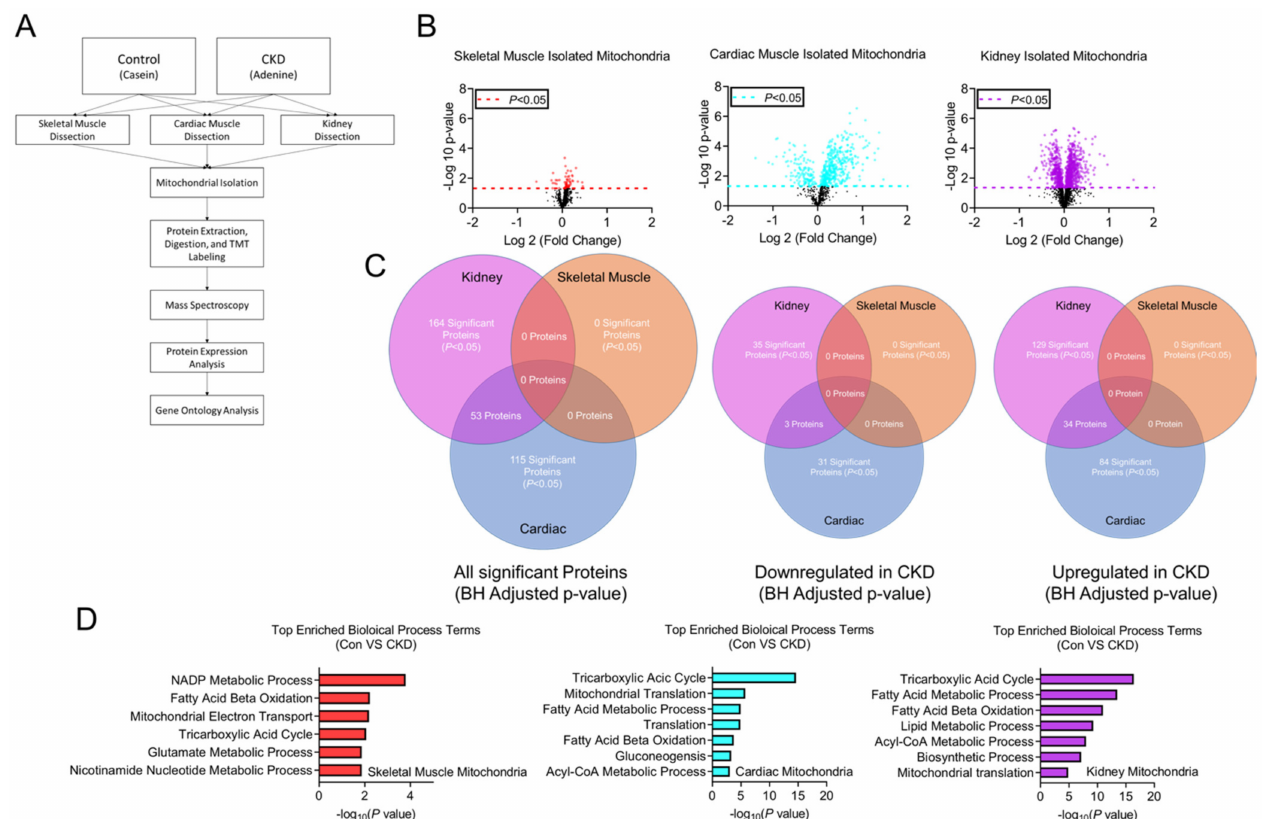
Figure 6. Mitochondria from skeletal muscle, cardiac muscle, and renal tissue express unique mitochondrial proteome alterations in CKD. ( A ) Experimental approach for TMT-labeled proteomic assessments; ( B ) Protein abundance analysis of skeletal muscle, cardiac muscle and renal tissue mitochondria volcano plots using. Dashed lines indicate the unadjusted - log10 p = 0.05 demonstrating differentially expressed proteins in CKD mice; ( C ) Venn diagram comparisons of all significantly expressed proteins (adjusted p < 0.05), all downregulated proteins, and all upregulated proteins in all three tissues of control and CKD mice; ( D ) Gene ontology analysis of differentially expressed proteins in skeletal muscle, cardiac muscle, and renal tissue isolated mitochondria in control and CKD mice ( n = 3/group/tissue).